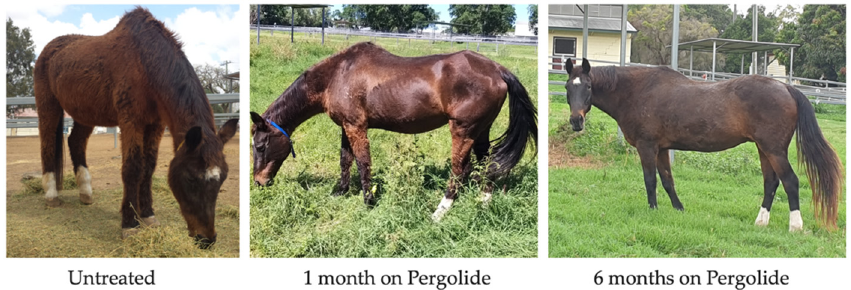
Figure 5. 25-year-old Australian Stockhorse mare untreated; after one month of pergolide and six months of pergolide.